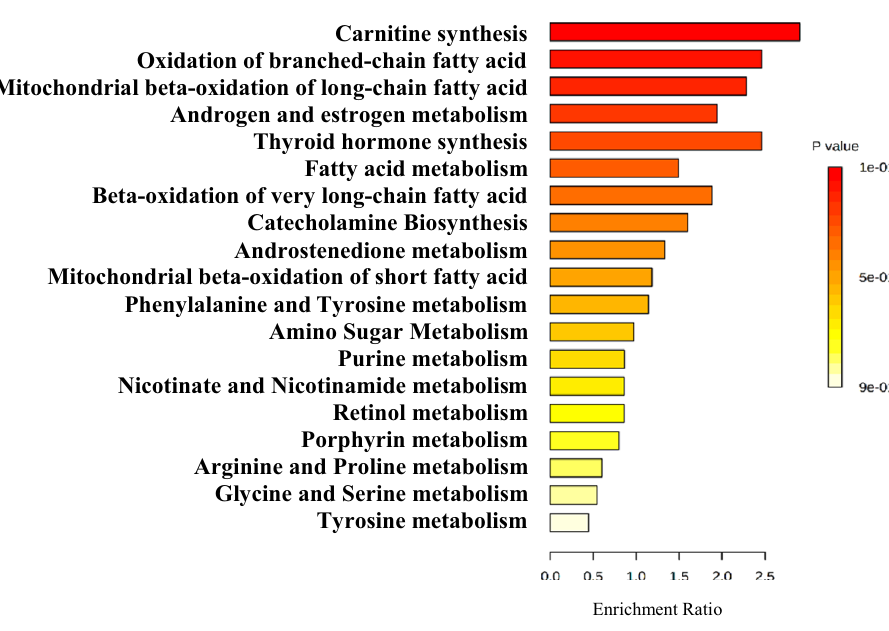
Figure 3. Pathway analysis of markers metabolites of testosterone levels identified by sPLS-DA analysis. Metabolic Set Enrichment Analysis (MSEA) results based on search in The Small Molecule Pathway Database (SMPDB) library. Bar graphs illustrating the enrichment overview of the top metabolic pathways of metabolites present in clusters 2, 3, and 4 with recovery or tendency to recover the respective abundance profiles. Color intensity (yellow to red) indicates their increasing statistical